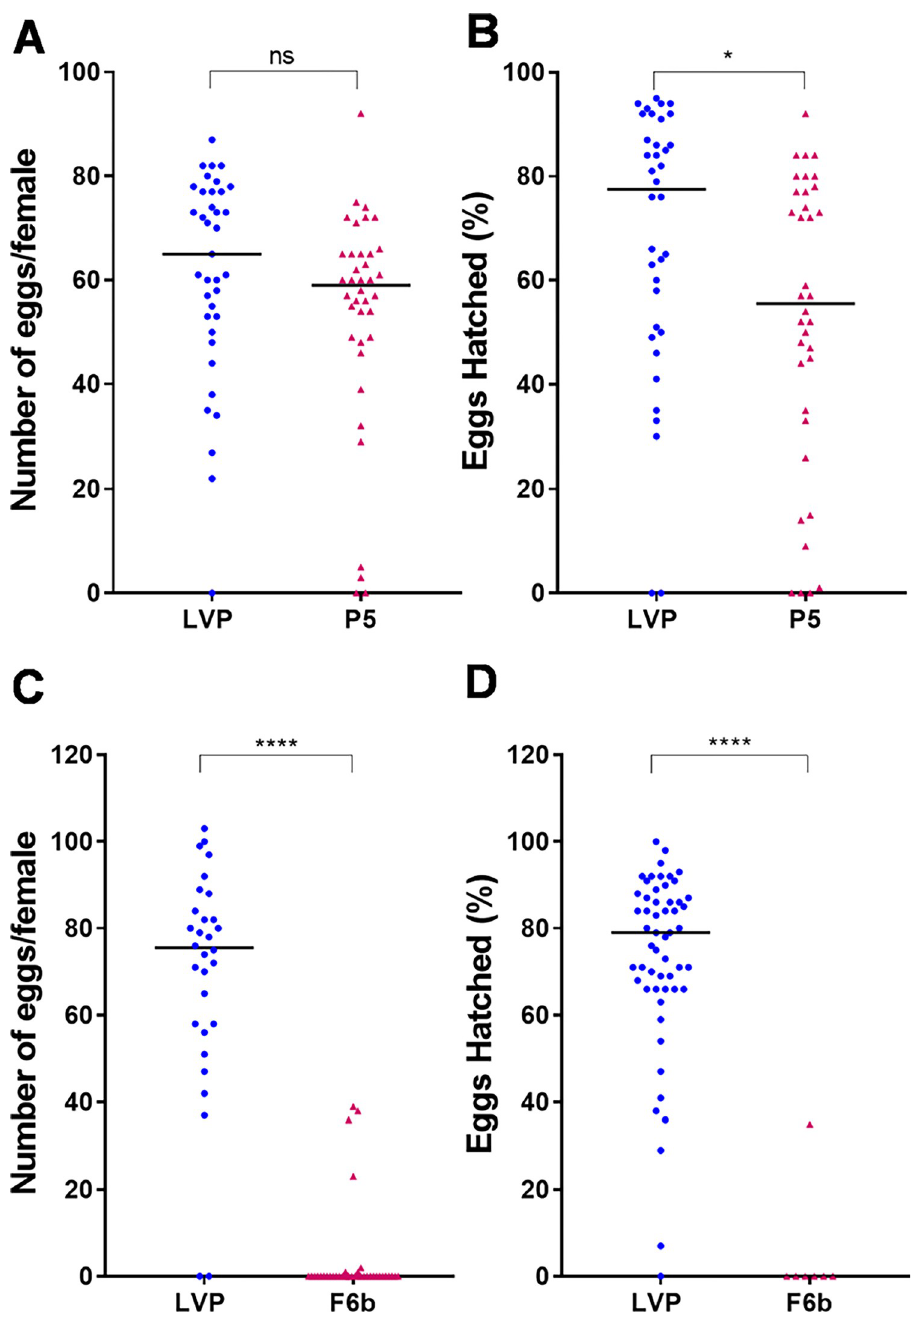
Fig 4. Reduced fecundity and fertility in masculinized transgenic females. Transgenic females were offered a blood meal in the artificial apparatus or through a warm blood-soaked cotton. Blood fed females were put into an Eagal plate and number of eggs per female (fecundity) and number of larvae per eggs (fertility) was scored. ( A ) Fecundity from P5, ( B ) fertility from P5 ( C ) fecundity from F6b, and ( B ) fertility from F6b transgenic lines. A Mann–Whitney U test was used to evaluate statistical significance. ns: P > 0.05; ��� : P <